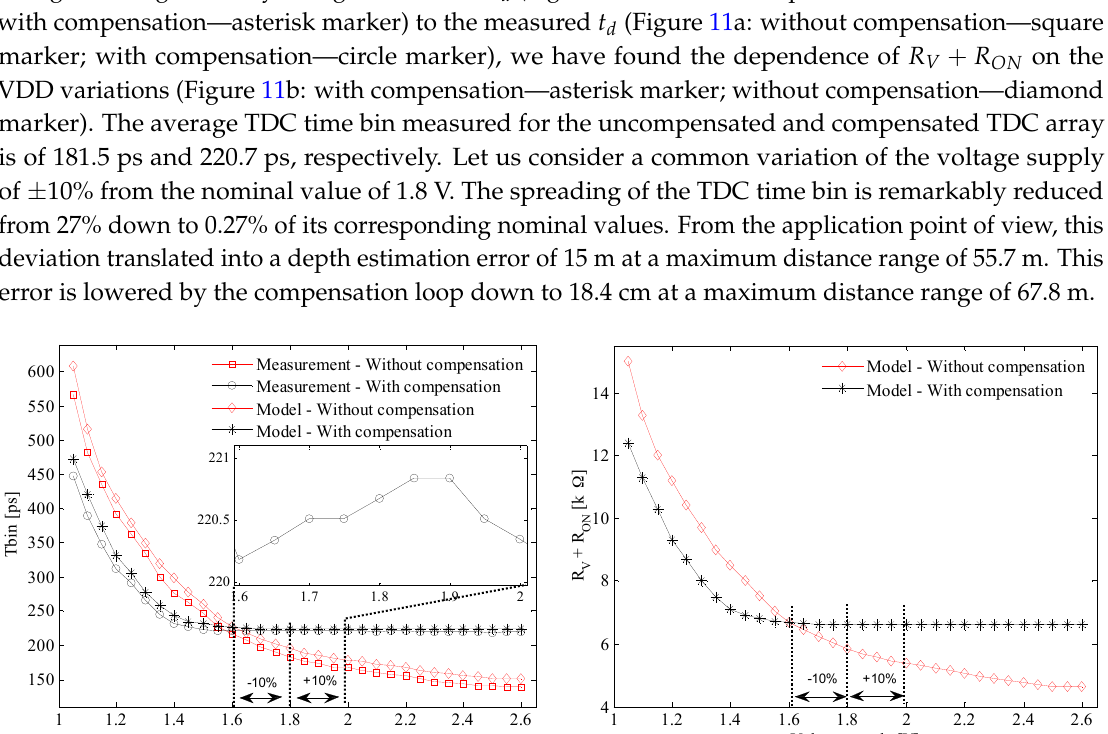
( b ) Figure 12. Measured synthesized frequencies’ dependence on the variation of VDD: ( a ) master VCRO output frequency and ( b ) loop filter voltage.